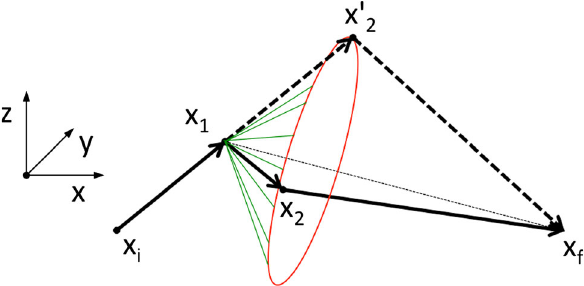
Fig. 5 Non-Relativistic PI in three dimensions with two intermediate steps (indicated by the red dashed line in Fig. 5), this config- uration is actually an overcounting, since it is already considered by a one slicing path x i → x 2 → x f . This can happen, but it is actually numerically irrelevant since it corresponds to a one dimensional subset of the three dimensional volume d 3 x 2